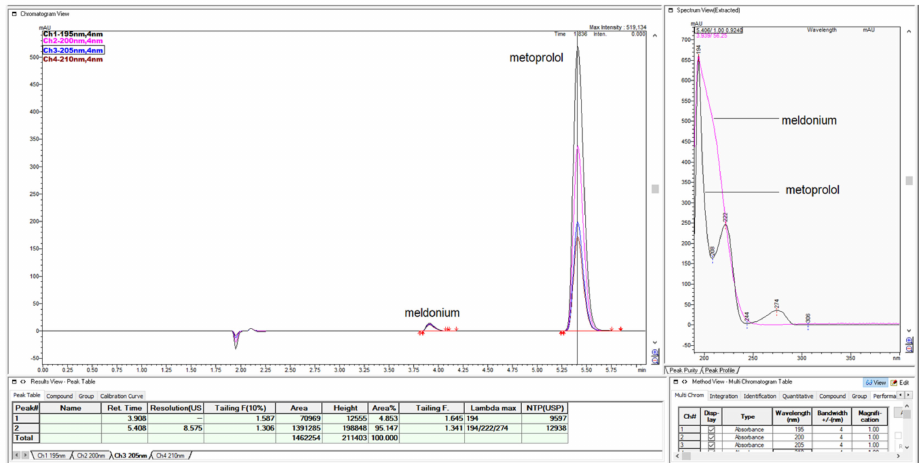
Figure 19. Chromatogram with 50% ACN and 50% diluted TFA with full size chromatogram below, monitored and overlaid at 4-channels with 4 different